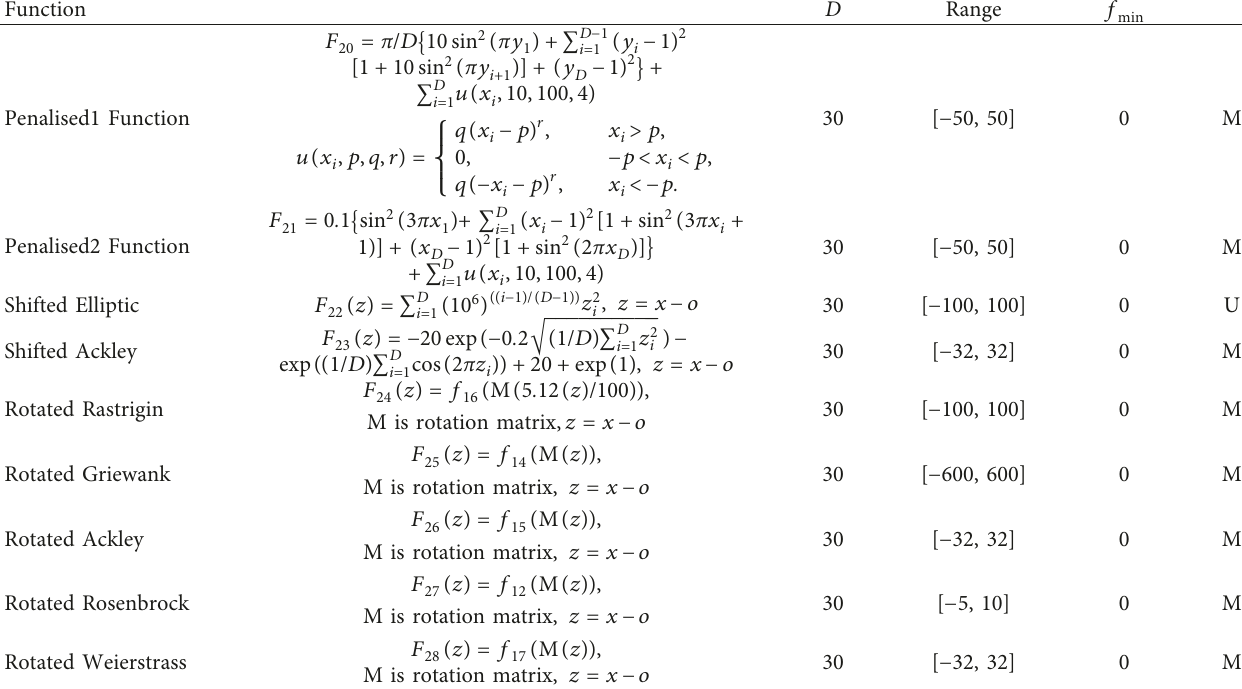
Table 4: Comparison (atomic % and weight %) of LiCoO